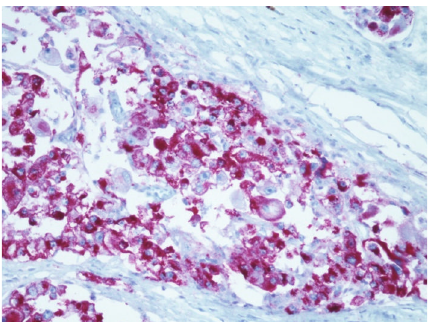
Figure 5: Immunohistochemical stain positive for